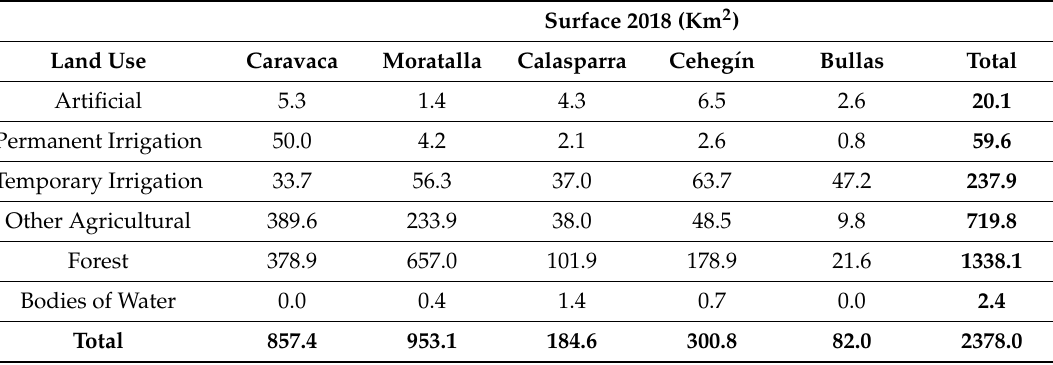
Table 4. Distribution of coverage and land use by municipalities (2018).